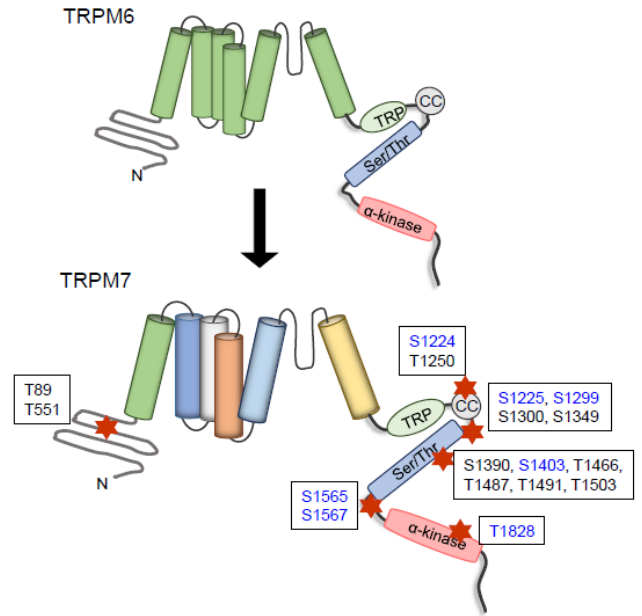
Figure 3. Transphosphorylation of TRPM7 by TRPM6. TRPM6 is able to induce phosphorylation of TRPM7 in the indicated residues. Red stars indicate the location of the residues. Residues in blue are also residues of autophosphorylation.